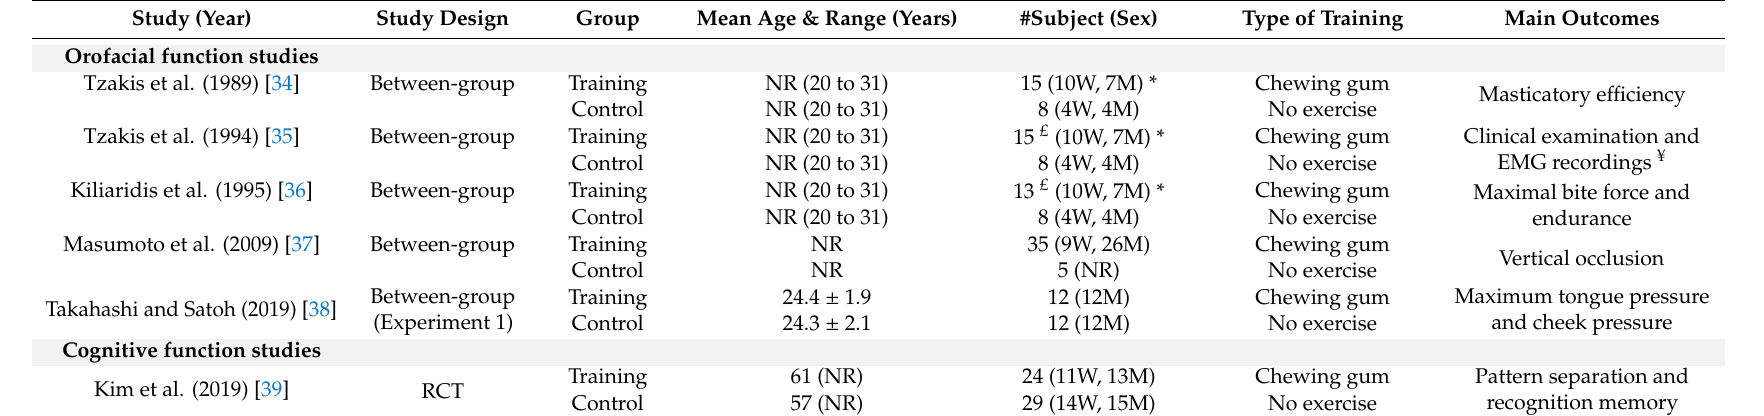
Table 1. Study design and characteristics of the participants of the included studies.